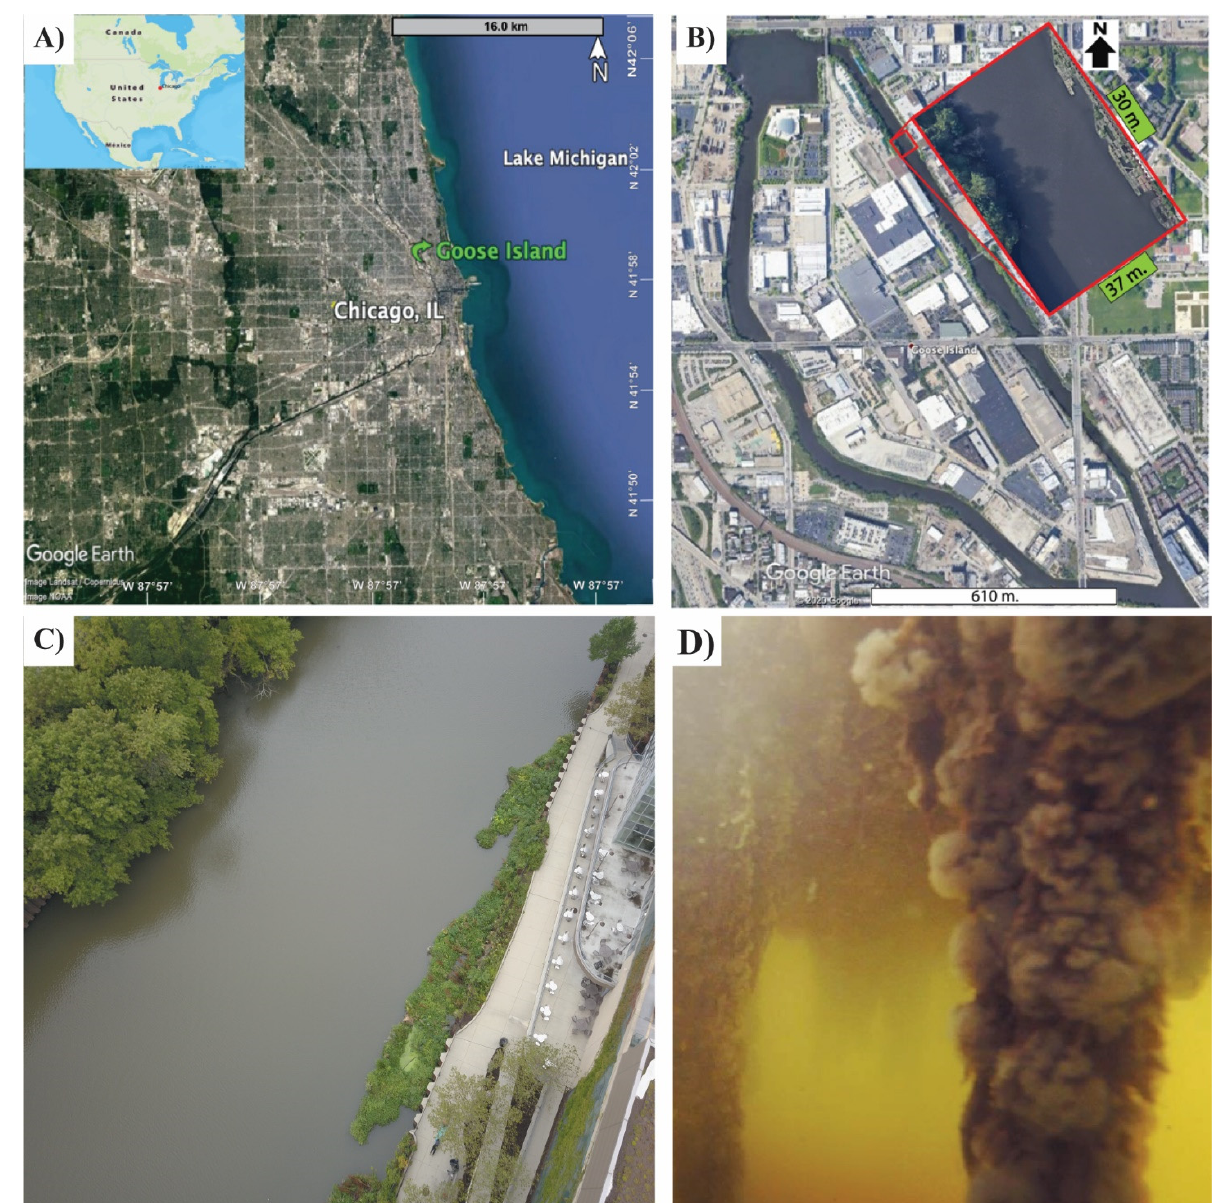
Figure 1. Location of the AFW along Goose Island Canal. ( A ) General location within Chicago, Illinois, USA (base image from Google Earth). ( B ) AFW location on the eastern edge of Goose Island Canal of the Chicago River. The general location is outlined in red. The inset shows the garden (3 m × 30 m) in relation to the river (37 m × 30 m) ( C ) An overhead image of the AFW. ( D ) Image of the system of roots within water column underlying the AFW.